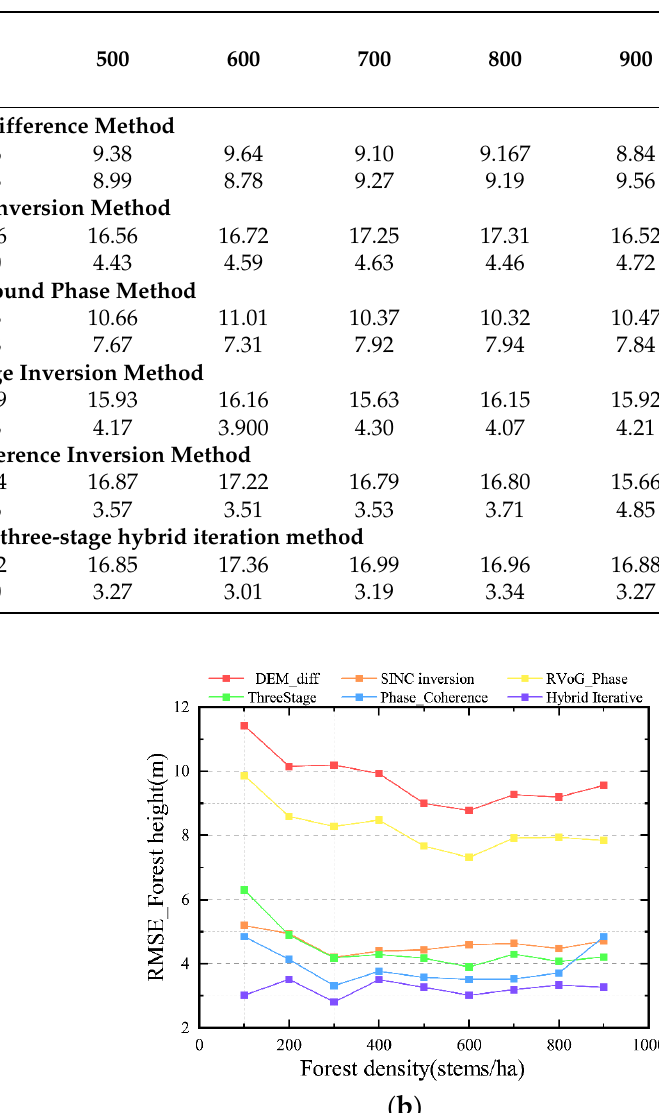
Table 3. Using simulated datasets of 100–900 stems/ha, six forest height inversion techniques produced forest height and error results.